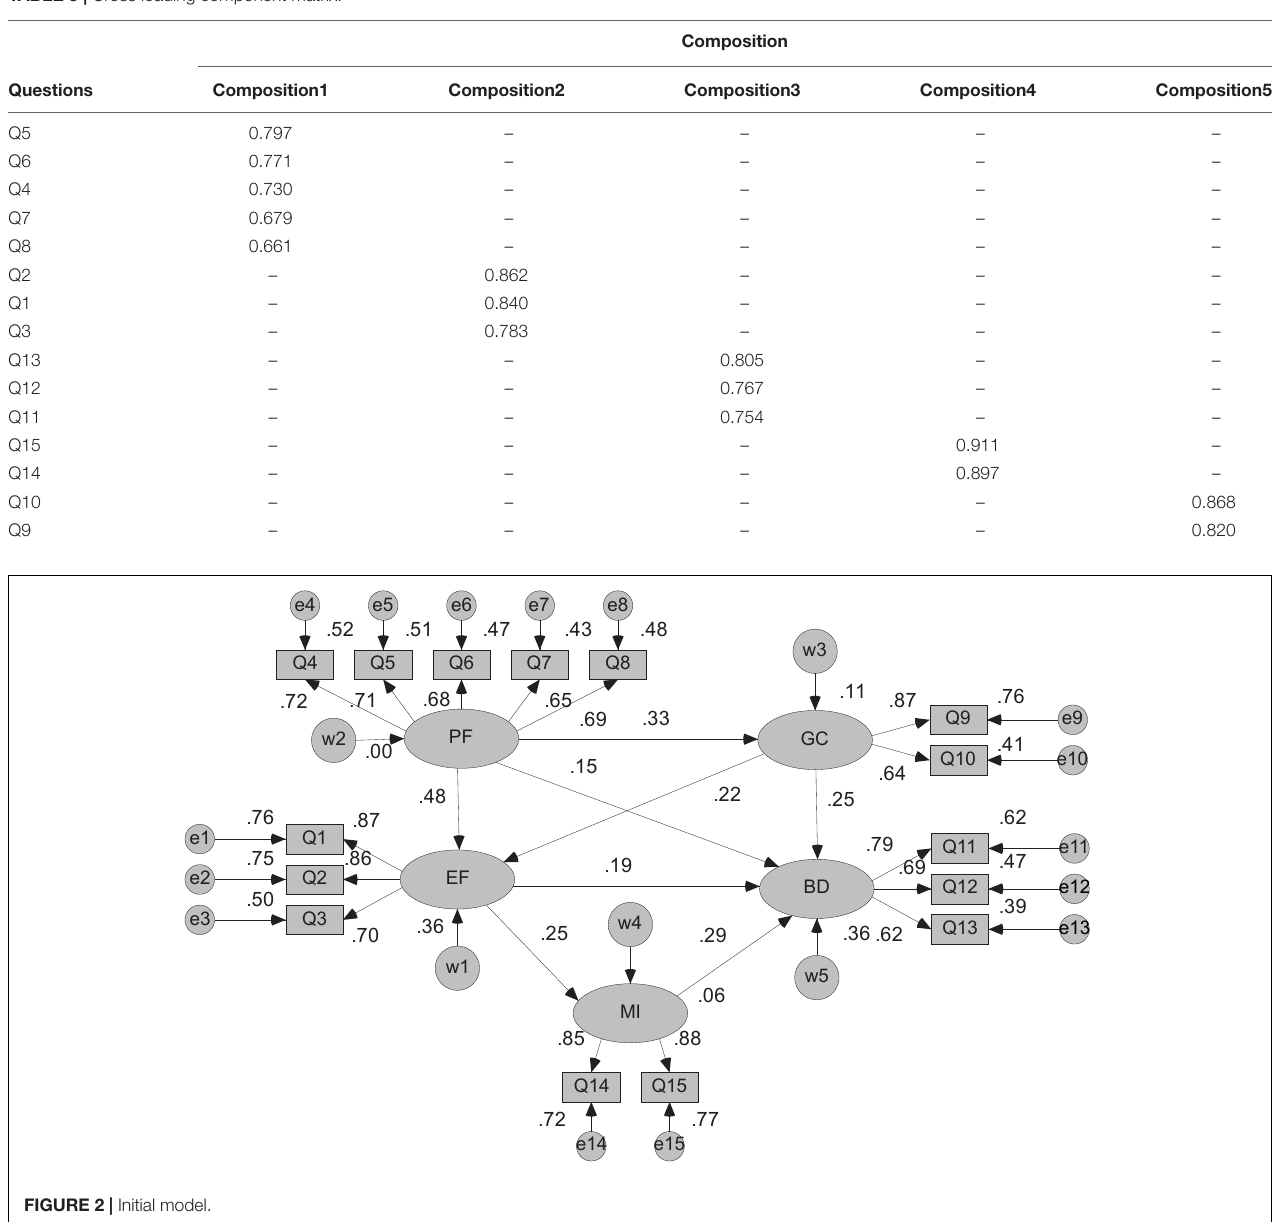
TABLE 3 | Cross loading component matrix.